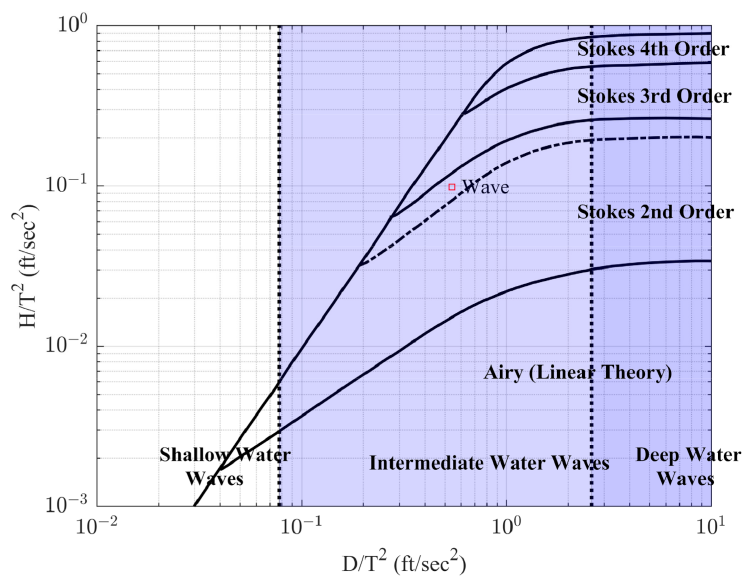
Figure 12. The wave conditions for the monochromatic wave used plotted on the Le Mehaute abacus. A MATLAB function designed by Byford [52] has been used to create the plot with the depicted wave